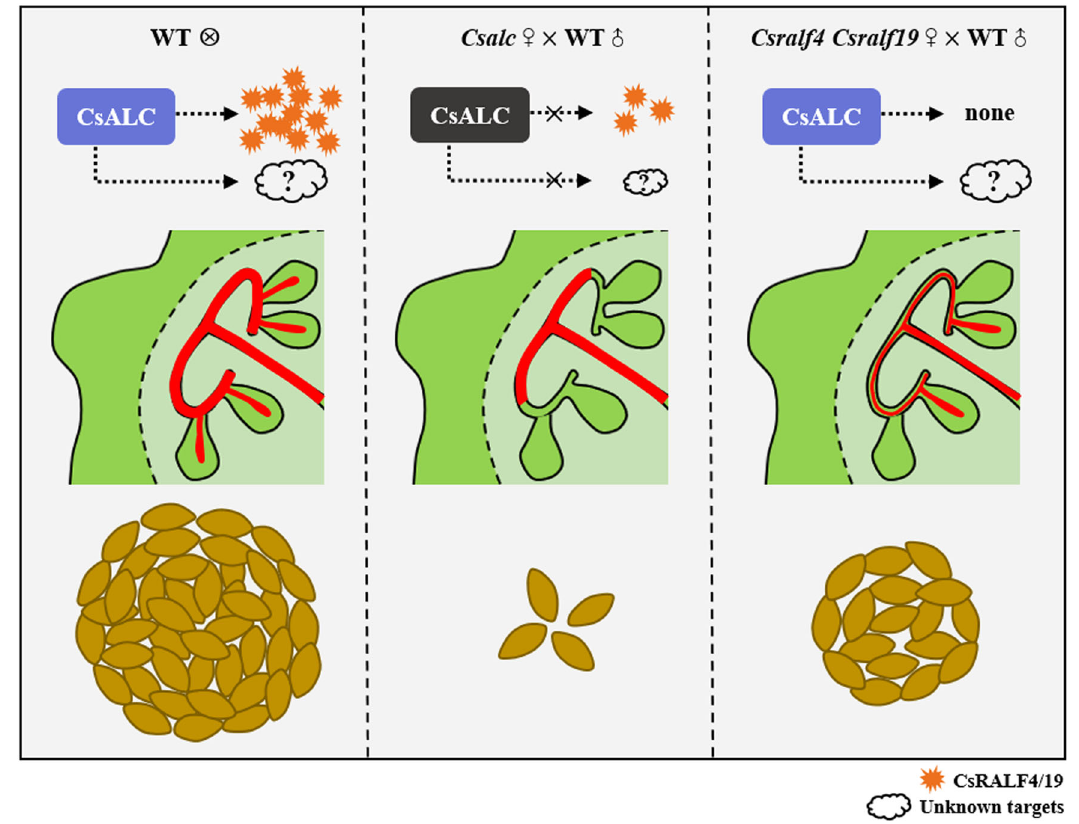
Fig. 7|A workingmodelforCsALCandCsRALF4/19 inpollentubeguidancein cucumber. In WT ovary, pollen tubes (in red) extend successively along the medial-, lateral- and terminal-TTand eventually enter ovules, producing hundreds of seeds per fruit in cucumber. In Csalc mutant, pollen tubes fail to re-orient to ovules and are blocked atthe lateral TT, partially due tothe decrease of